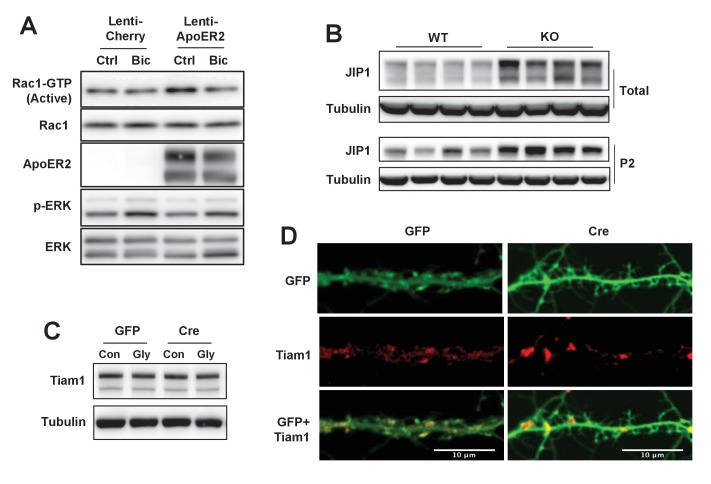
IDOL effects on Rac1 activity involve JIP1 and TIAM1.(A) Immunoblot analysis of endogenous GTP-bound (active) Rac1 and total Rac1 in the protein lysates from Mylipflox/flox cortical neurons transduced with either Lenti-Cherry, or Lenti-ApoER2. Neurons were transduced at DIV 5 and harvested at DIV 16–18. Neurons were treated with bicuculline (40 µM) for 10 min before harvest. Each lane represents pooled samples from three wells of a 12-well-plate. Representative data are presented from 2 independent experiments. (B) Immunoblot analysis of total protein lysates (upper) and P2 fractions (lower) from cortex of 4-week-old wild type and IDOL-deficient mice. Lanes represent samples from individual mice. (C) Immunoblot analysis of total protein lysates from Mylipflox/flox hippocampal neurons transduced with either AAV-CamKII-GFP or AAV-CamKII-CRE-GFP and treated with/without glycine. (D) Representative images showing immunofluorescence staining of dendrites from Mylipflox/flox hippocampal neurons transduced with either AAV-CamKII-GFP or AAV-CamKII-CRE-GFP. Neurons were transduced at DIV 5, and fixed and stained at DIV 20. Green, GFP; red, Tiam1. Scale bars, 10 µm.